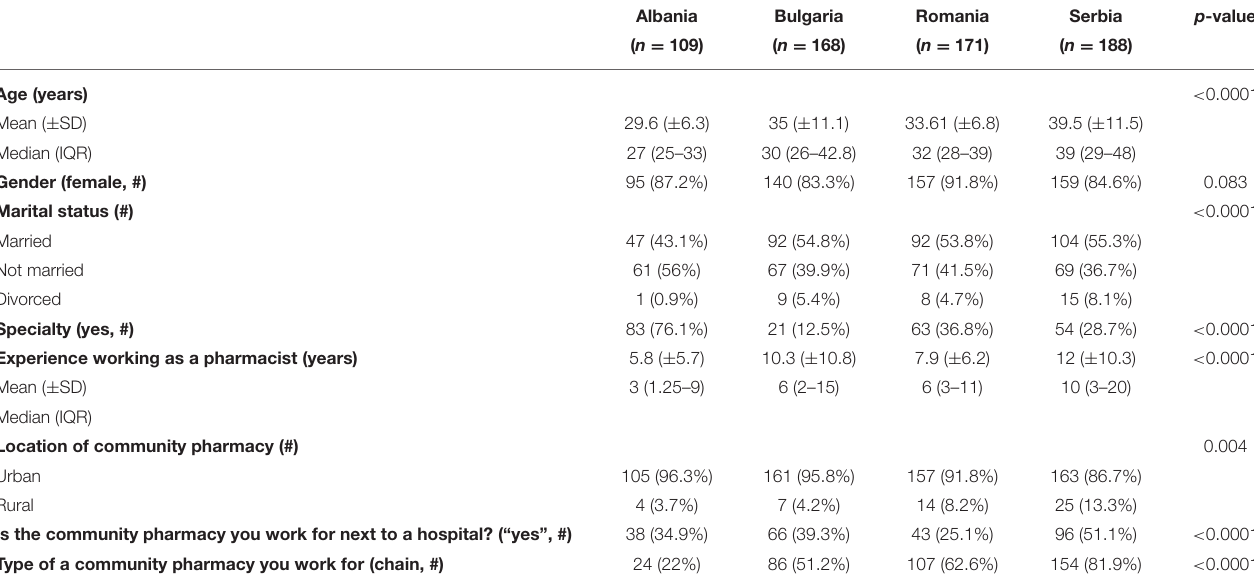
TABLE 1 | Sociodemographic characteristics of